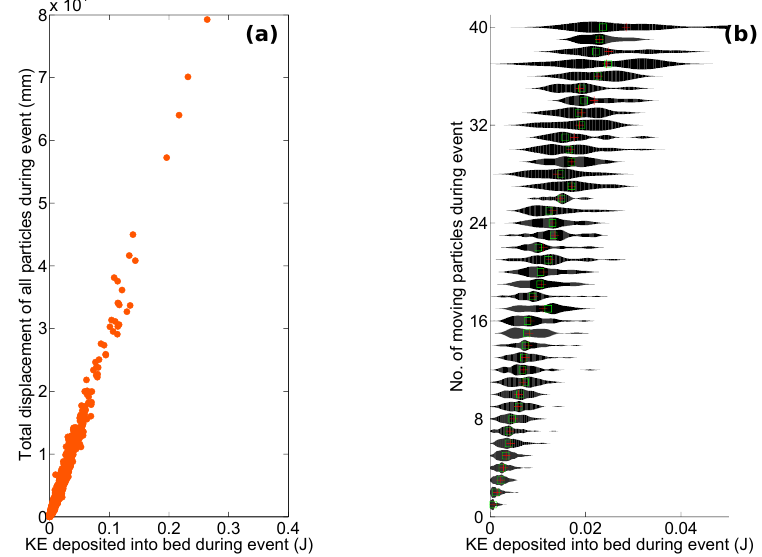
Figure 10. Particle mobility as a function of kinetic energy (KE) deposited in the bed for an event. (a) Cumulative displacement for all mobile particles during an event increases linearly with KE deposited. (b) Probability distribution of the amount of deposited KE necessary to entrain a given number of mobile particles. The mean of the distribution is displayed as a red cross, and the medians are shown as green